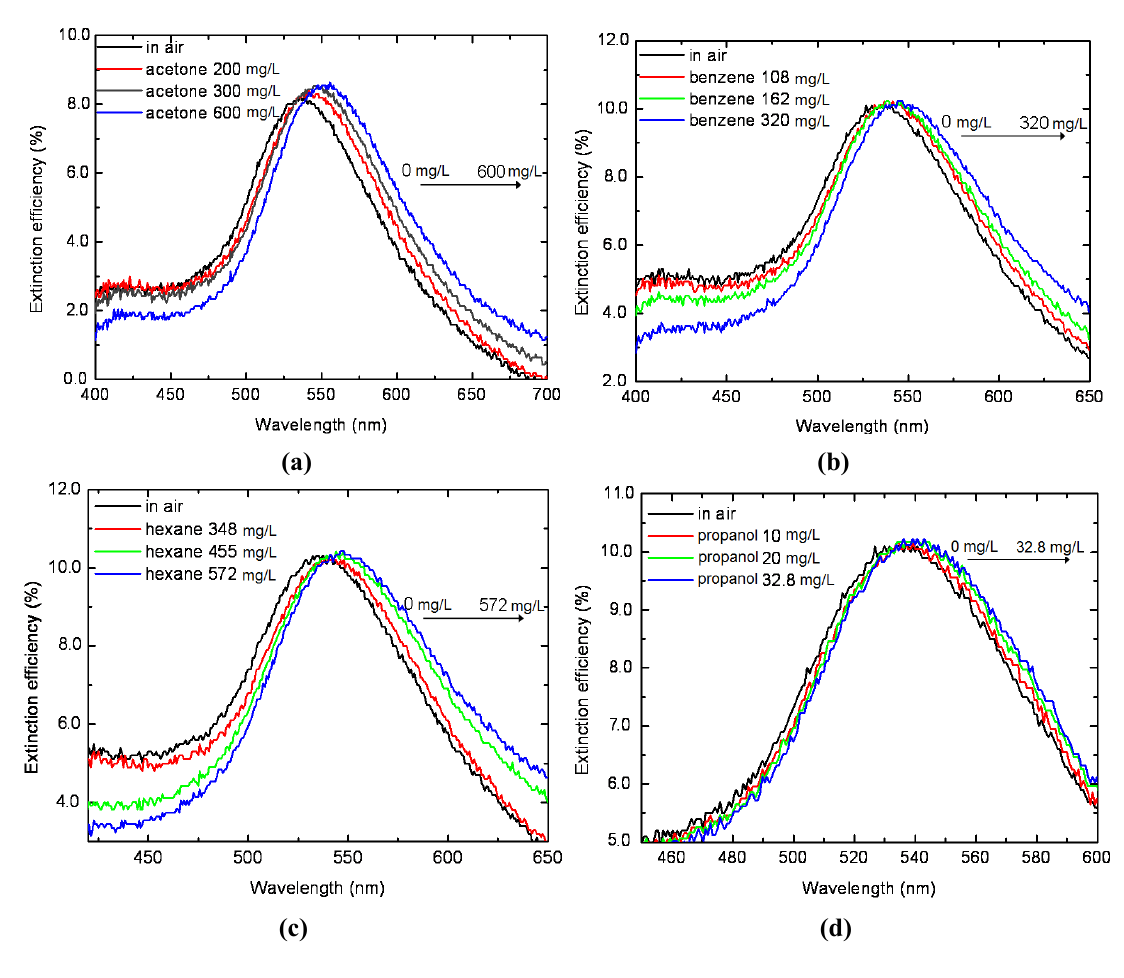
Figure 5. LSPR spectra responding to various vapors. (a) Acetone; (b) Benzene; (c) Hexane; (d)